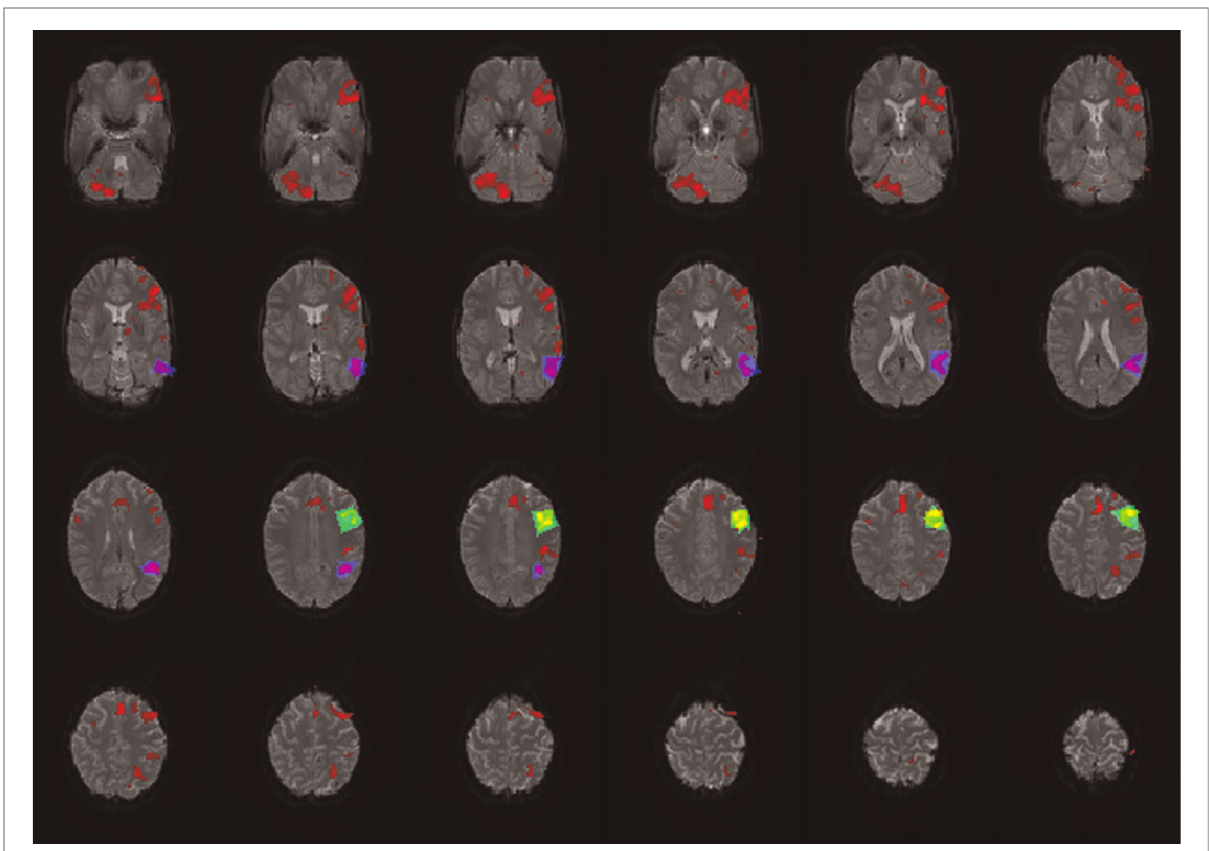
FIGURE 2 Exemplary map with broca ’ s (green/yellow), wernicke ’ s areas (blue/purple) and additional activations (red) marked. All activations that lay within the marked areas were attributed to the corresponding LA and were included as language activation in the calculation of the